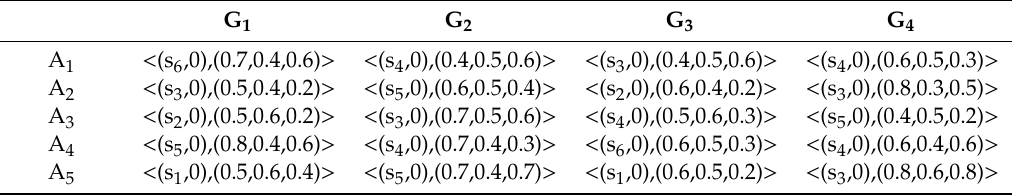
Table 1. Single-valued neutrosophic 2-tuple linguistic number (SVN2TLN) decision matrix.